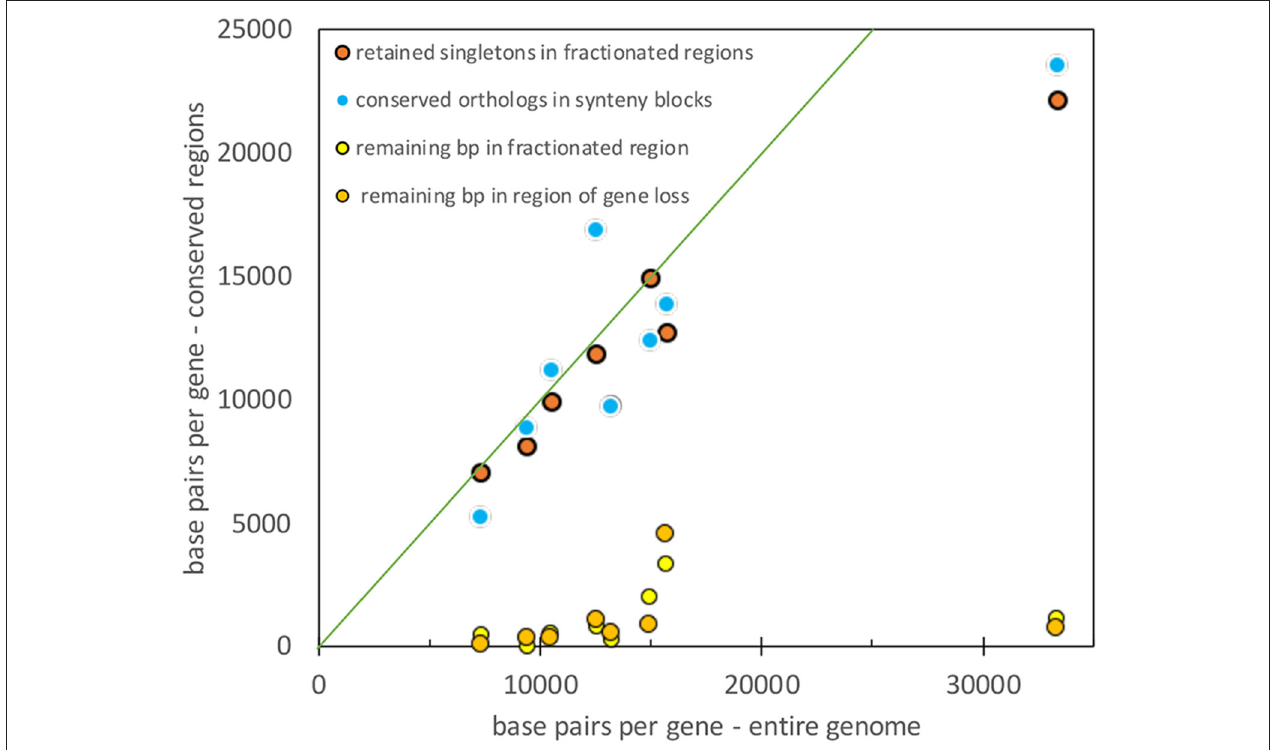
FIGURE 9 | Comparison of gene density in unfractionated regions and the whole genome. Diagonal represents equality between the two